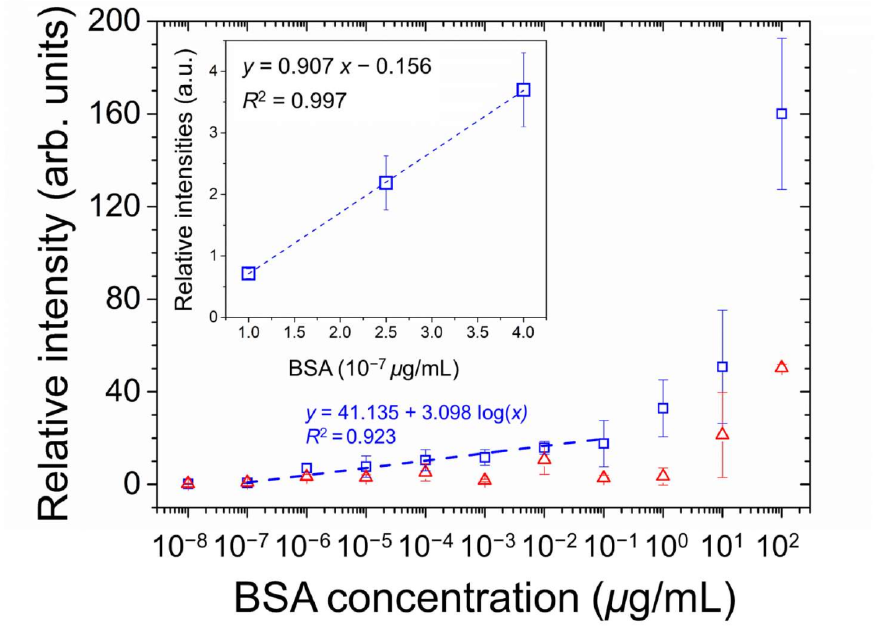
Figure 6. Quantitative analysis of the optical responses of E7 (open squares) and 5CB (open triangles) at various concentrations of BSA on glass substrates coated with the PVA/DMOAP composite. The relative intensity of the brightness of the optical texture in Figure 5a,b were determined by the image processing program ImageJ and plotted against the logarithmic BSA concentration. The linear curve was illustrated in the inset to calculate the LOD. Error bars represent standard deviations calculated from at least three independent experiments. The dotted line represents the fitted regression line, with the determination coefficient R 2 given in the